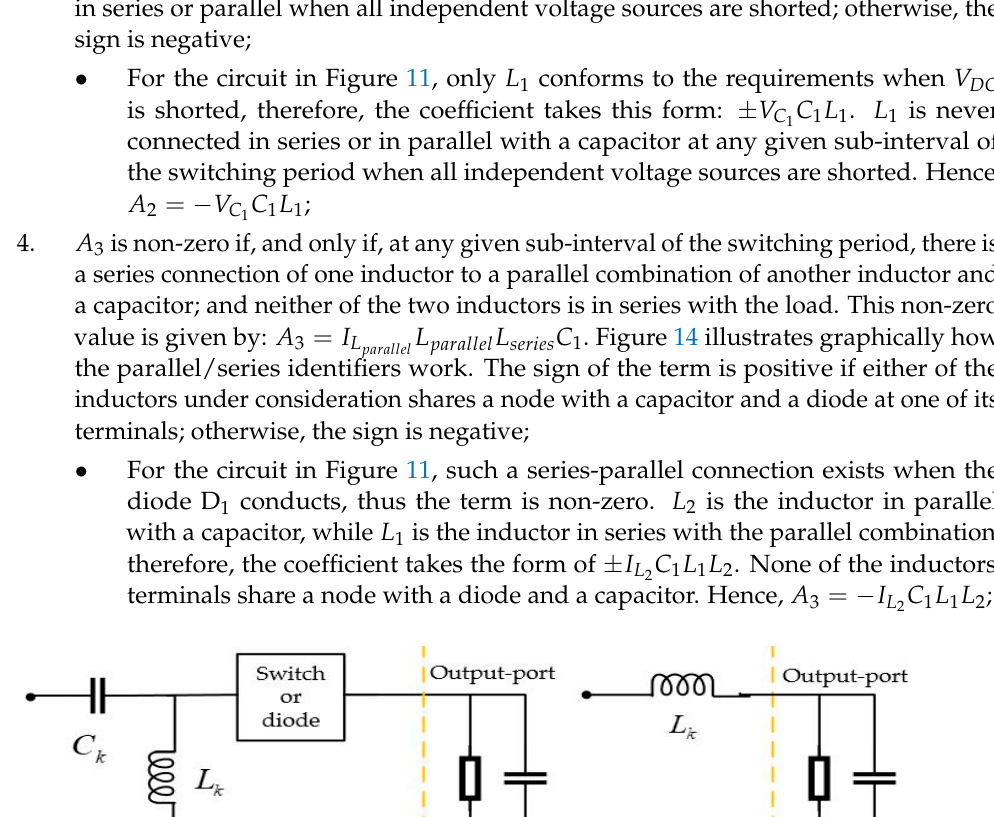
Figure 13. Pictorial representation of double switch connection.